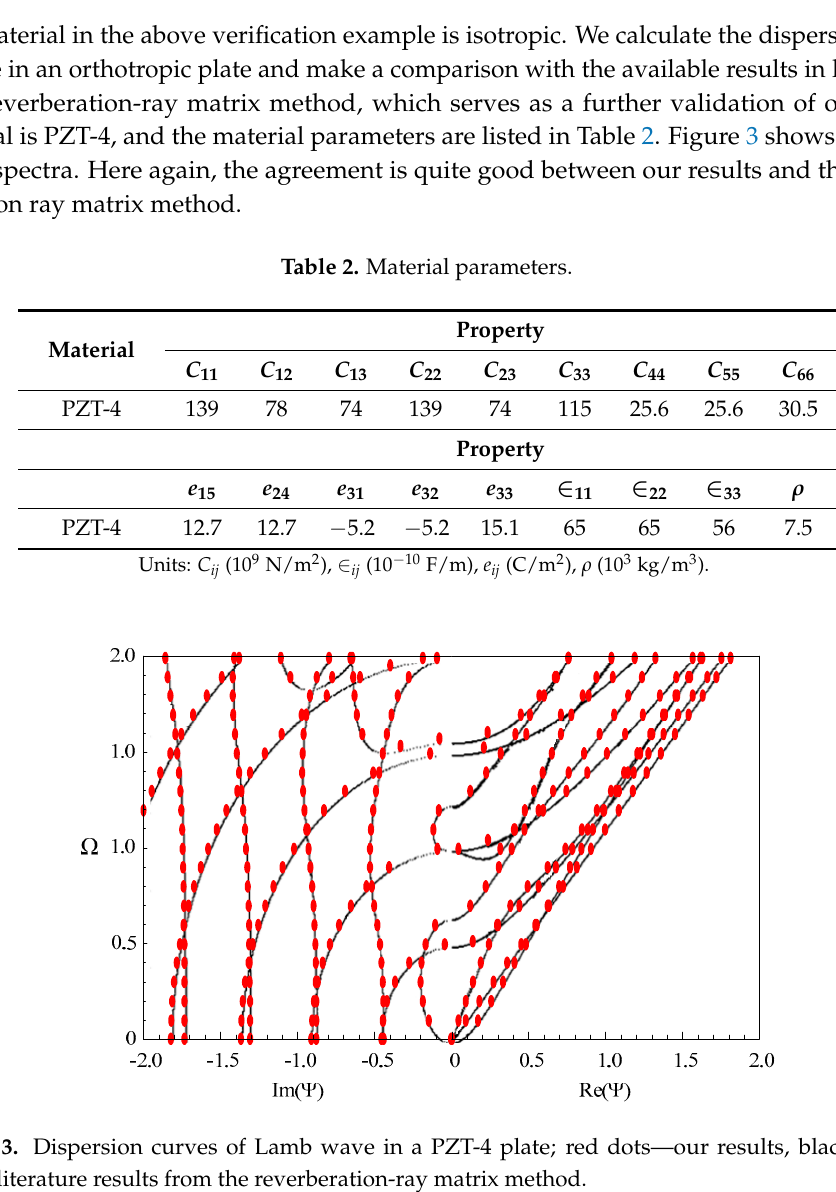
Figure 4. Dispersion curves of propagating Lamb-like wave in a linear functionally graded piezoelectric-piezomagnetic material (FGPPM) plate with various “ M ”.